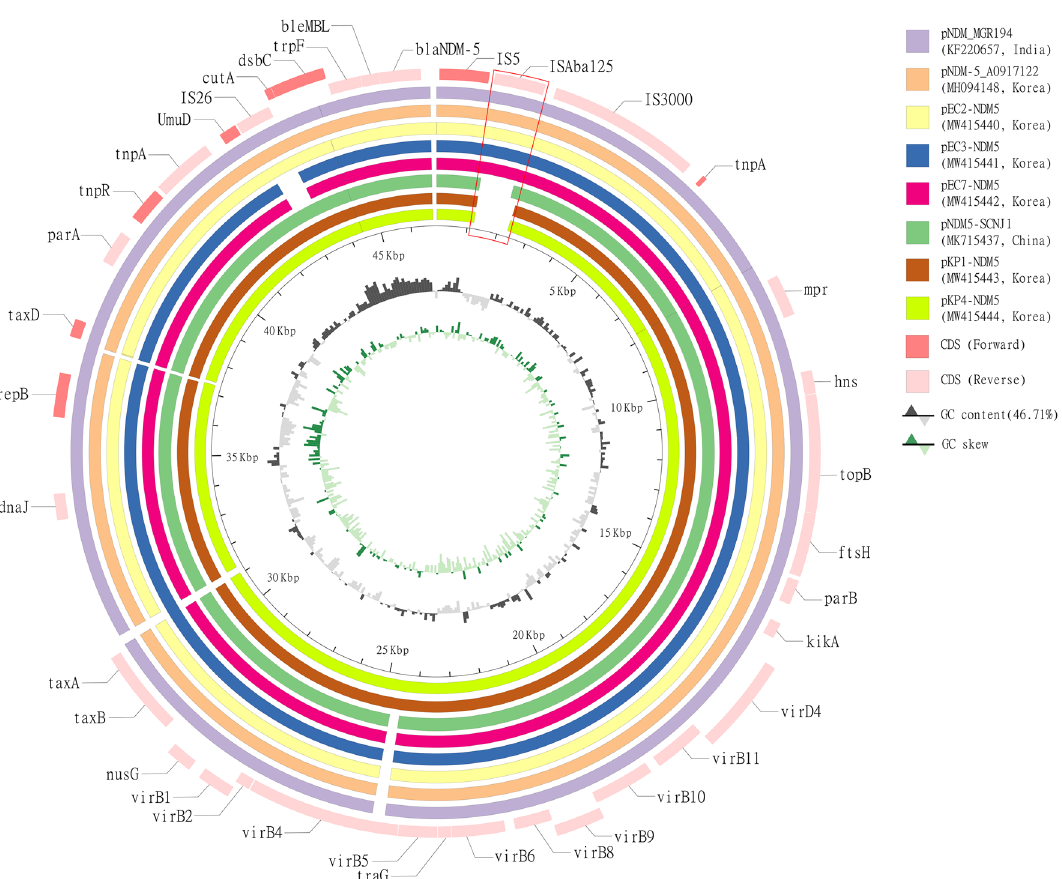
Figure 2. Schematic map of comparative circular genome structure analysis of 8 IncX3 plasmids. Circular maps were used to illustrate and compare the backbone and the location of the genetic load region of plasmids. GC skew was featured based on data of pKP4-NDM5. Genome alignments were performed by Mauve 24 , and the circular map was generated with CIRCOS (http:// circos.